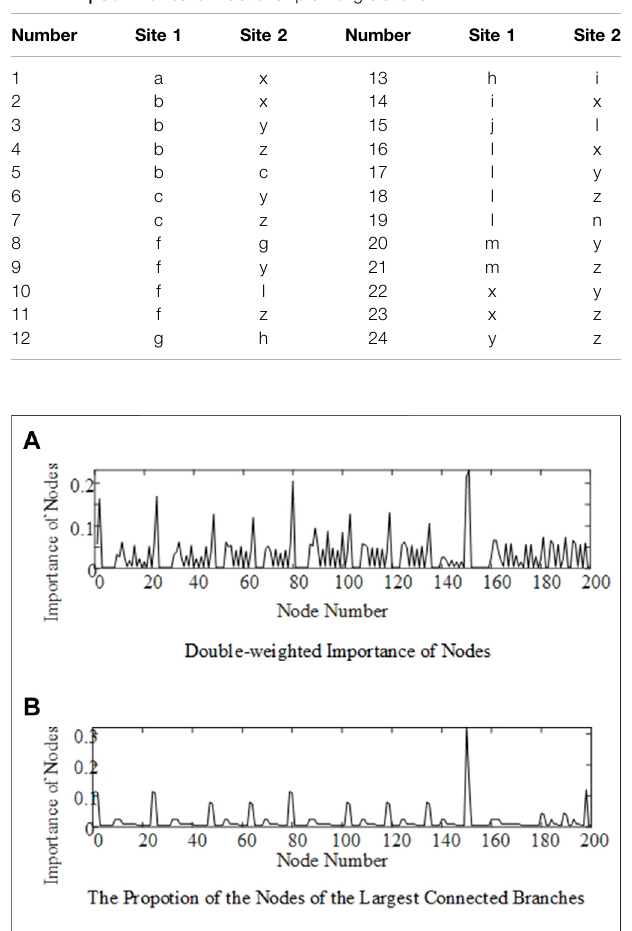
TABLE 1 | Communication relationship among stations.